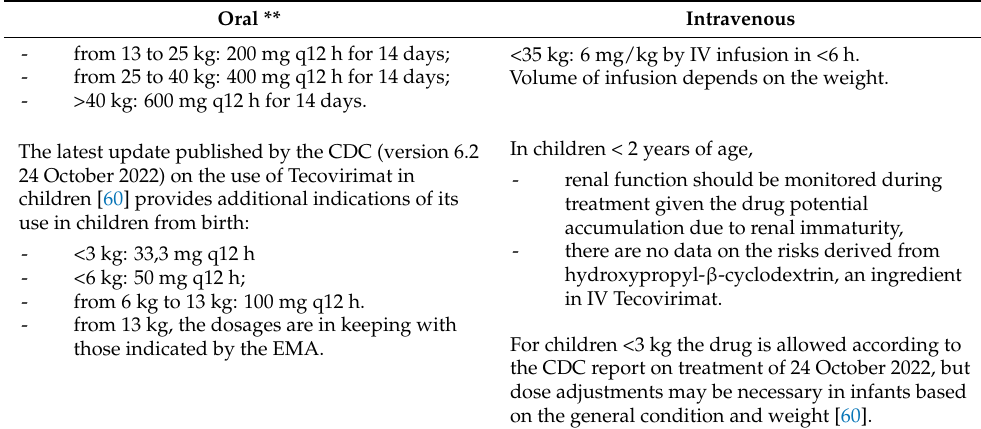
Table 1. Treatment with Tecovirimat in